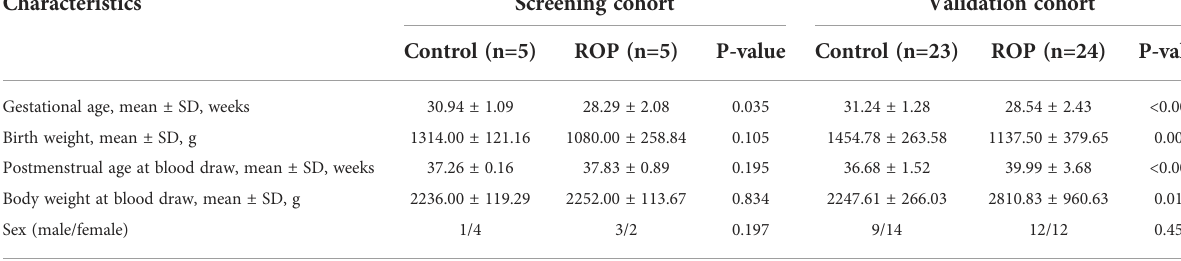
TABLE 1 Clinical characteristics of the individuals included in this